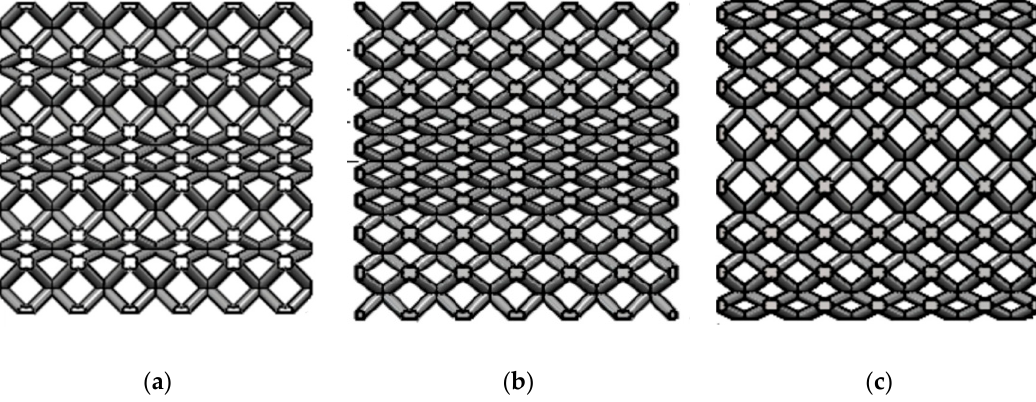
Figure 19. The gradient lattice structure topologies [190]: ( a ) gradient discrete; ( b ) gradient increasing; ( c ) gradient decreasing.